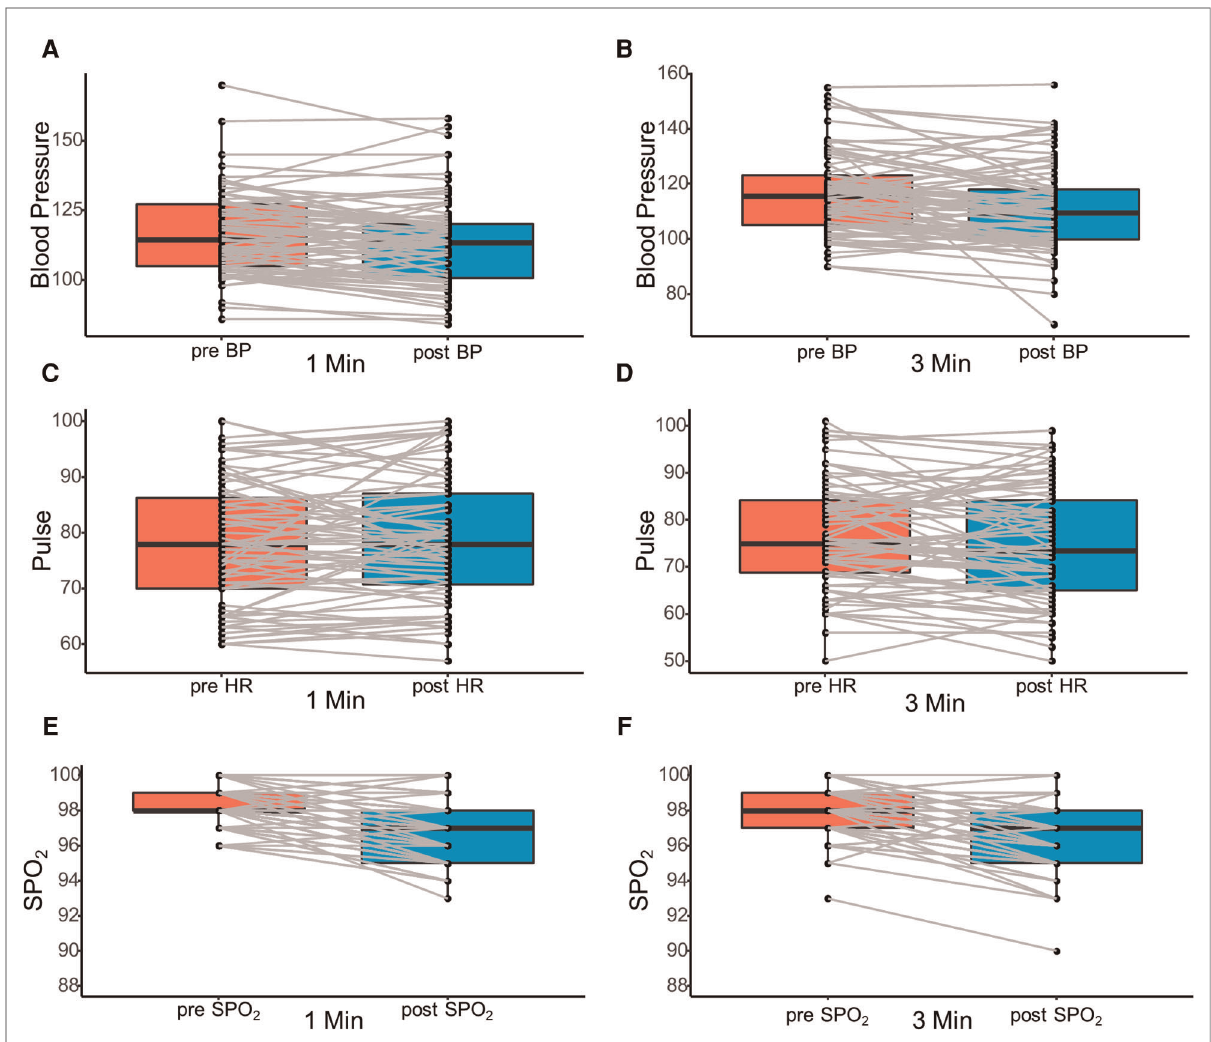
FIGURE 1 Illustration of the changes in arterial blood pressure ( A,B ), pulse ( C,D ), and SPO 2 ( E,F ) before and after colonoscopy procedure. SPO 2 , peripheral blood oxygen